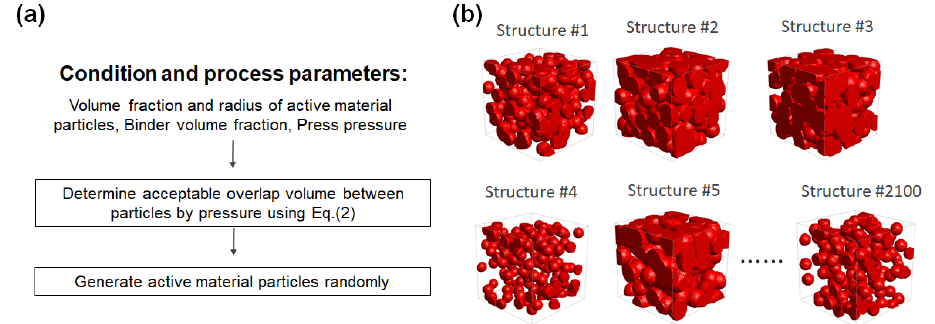
Figure 2. ( a ) Flowchart for the generation of the artificial structure with controllable process parameters, and ( b ) the generated mesoporous structures of the electrode (50 × 50 × 50 µm 3 ).